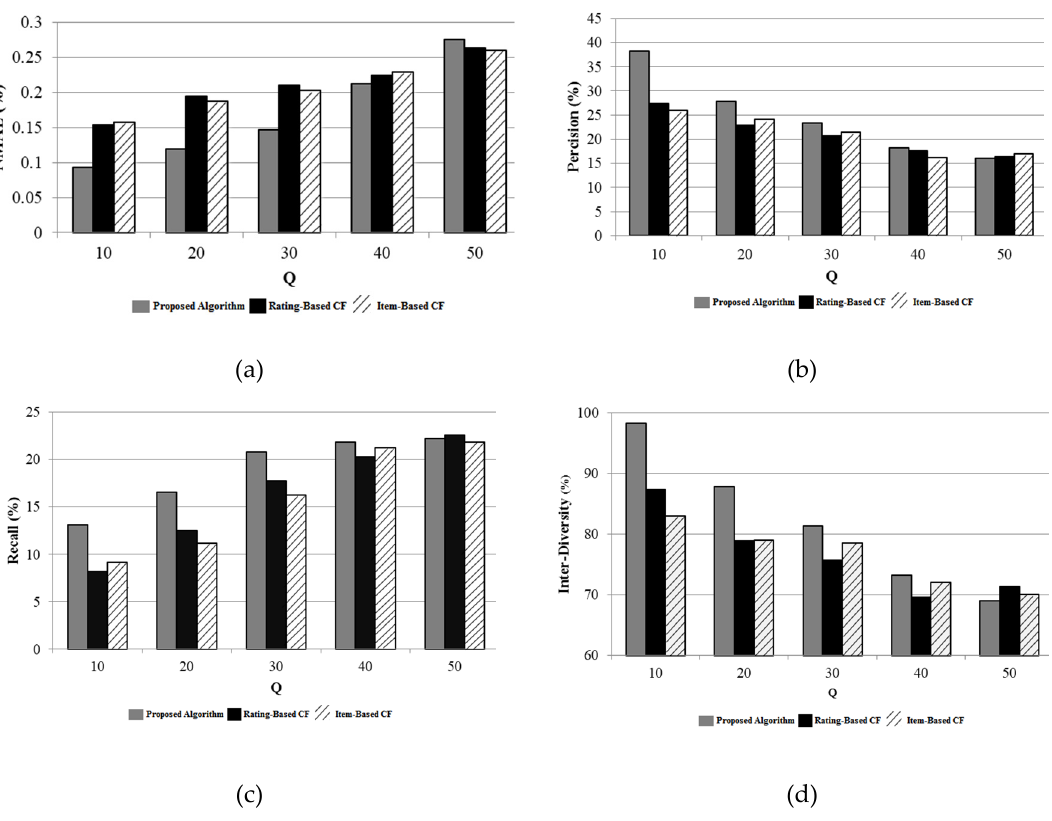
Figure 7. Performance evaluation of the proposed algorithm versus rating-based CF and item-based CF algorithm where Q is the number of recommended items; ( a ) normalized mean absolute error (NMAE); ( b ) precision; ( c ) recall; and ( d ) inter-diversity criteria comparison.